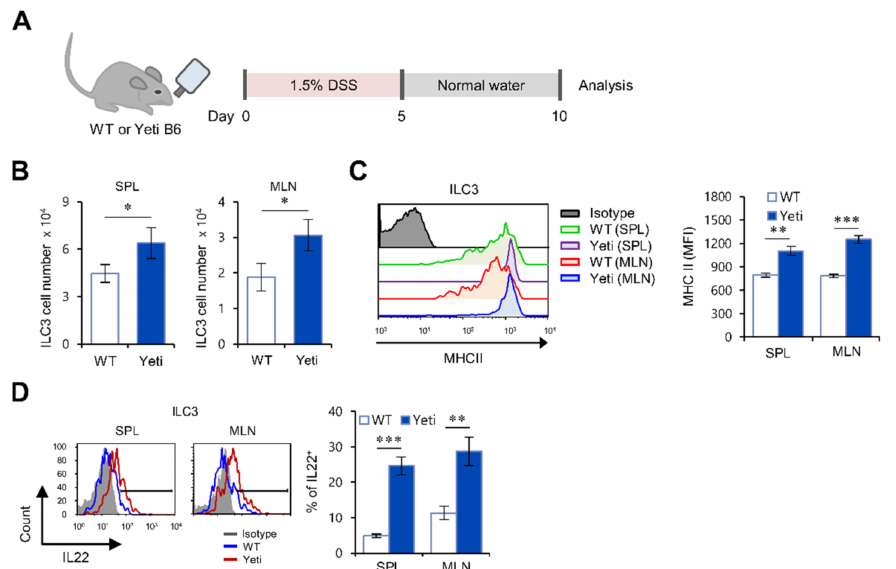
Figure 1. Dysregulated expression of interferon-gamma (IFN γ ) increases IL22-producing type 3 innate lymphoid cells (ILC3) in dextran sulfate sodium (DSS)-treated Yeti mice. ( A ) Experimental outline. Wild-type (WT) and Yeti mice were treated with 1.5% DSS as described in Materials and Methods. The spleen and mesenteric lymph nodes (MLN) were collected ten days after initiation of DSS treatment. ( B ) The absolute numbers of ILC3s (MHC II + ROR γ t + Lin − (i.e., CD3, CD19, NK1.1, CD11b, B220, F4/80, CD11c, Gr1, Fc ε R1 α )) in the spleen and MLN from WT and Yeti mice were assessed by flow cytometry. ( C ) MHC II expression by splenic and MLN ILC3s (ROR γ t + Lin − ) from these mice was analyzed by flow cytometry. Representative data (left panel) and their summary (right panel) are shown. ( D ) IL22 production by splenic and MLN ILC3s (MHC II + ROR γ t + Lin − ) from these mice was determined by flow cytometry on day 10. The mean values ± SD ( n = 4; per group in the experiment; Student’s t -test; * p < 0.05, ** p < 0.01, *** p < 0.001) are shown. One representative experiment of two experiments is